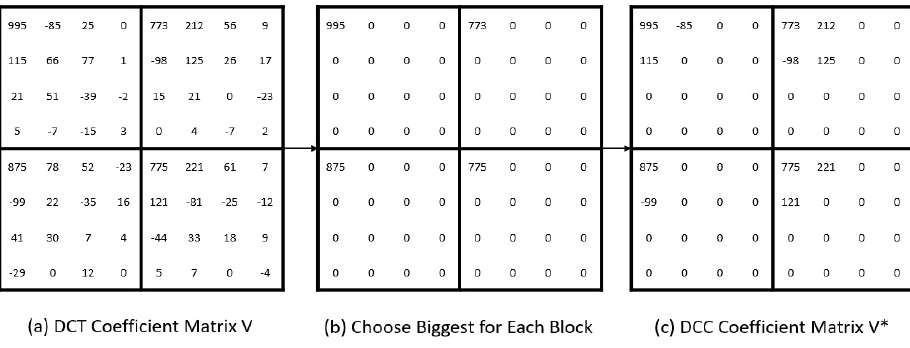
Figure 4. Example of coefficient cutting for a = b = 2, m = n = 8, r = 12. ( a ) DCT coefficient matrix after step 1. ( b ) Select the largest DCT coefficient for each block. ( c ) Select the remaining top ( r − a × b ) coefficients. Then, generate the DCC coefficient matrix.